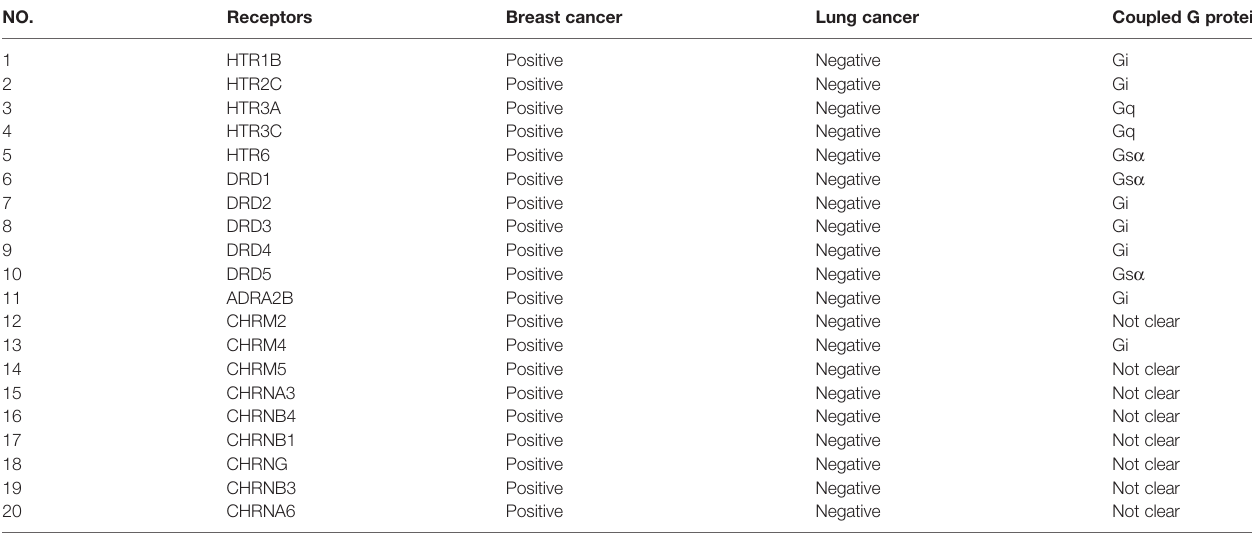
TABLE 2 | The 20 candidate receptors associating with survival of both breast cancer and lung cancer. NO.